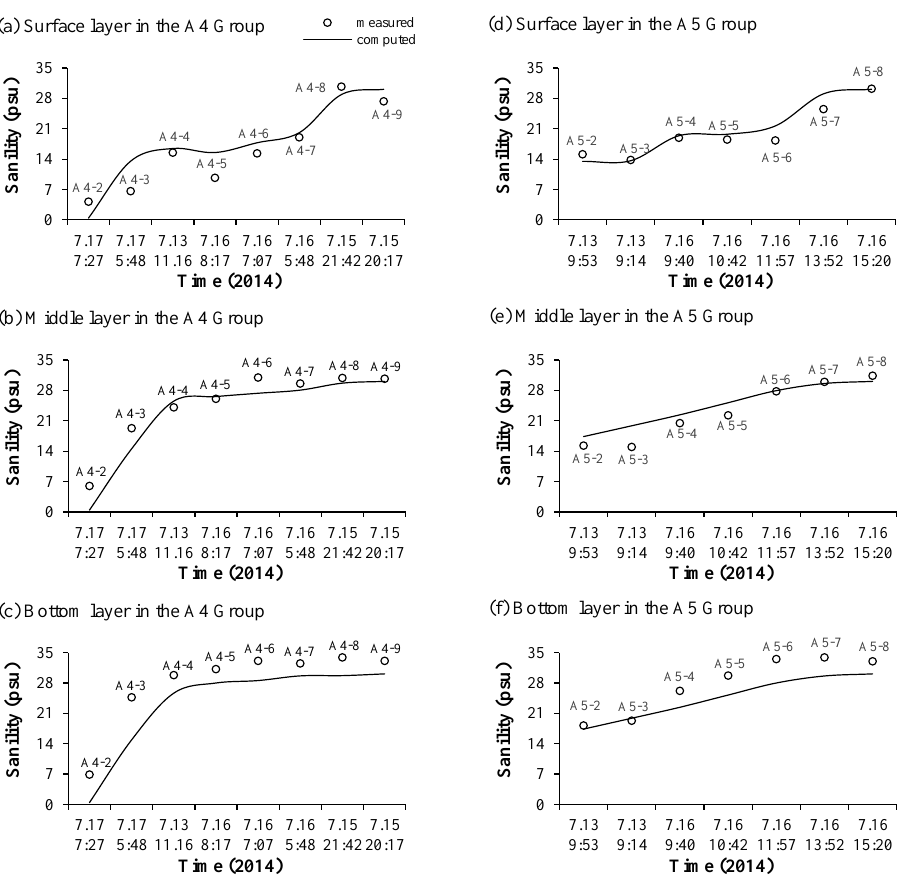
Figure 7. Verification of surface, middle and bottom salinity along two selected profiles for July